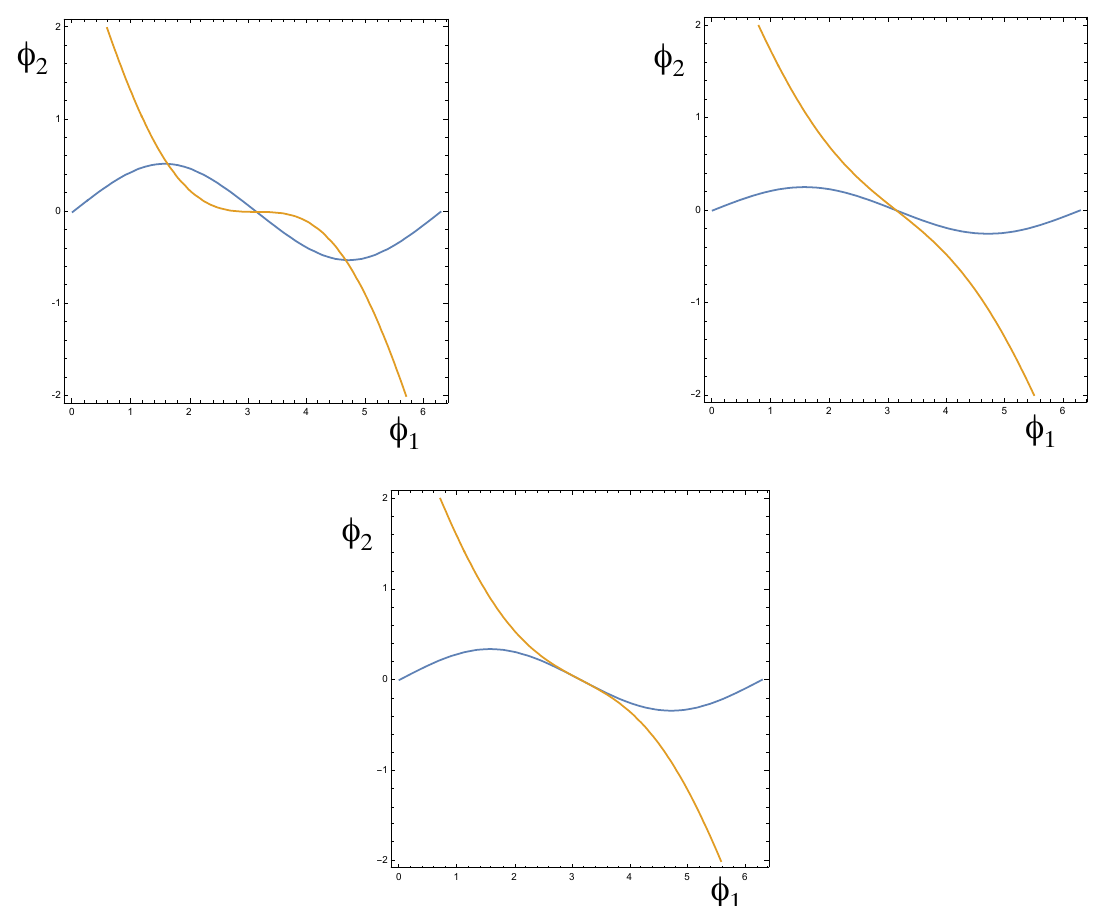
Figure 4 . Solutions of the stationarity conditions for N f = 2, (cid:22) 2 intersections of the curves shown in di(cid:11)erent color. The two situations with one or three solutions are shown together with the limiting case corresponding to a second order phase